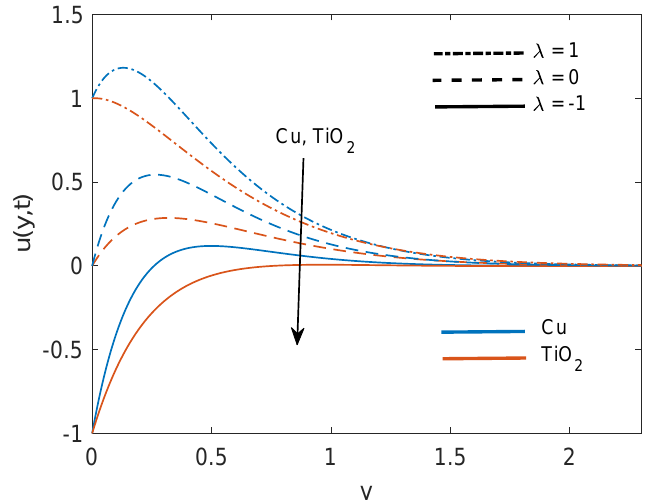
Figure 2. Velocity profile comparison for Cu-water and TiO 2 -water when Gr = 5, Nr = 1.5, K = 5, Q = 0.5, M 2 = 5, φ = 0.1 and t = 0.5.